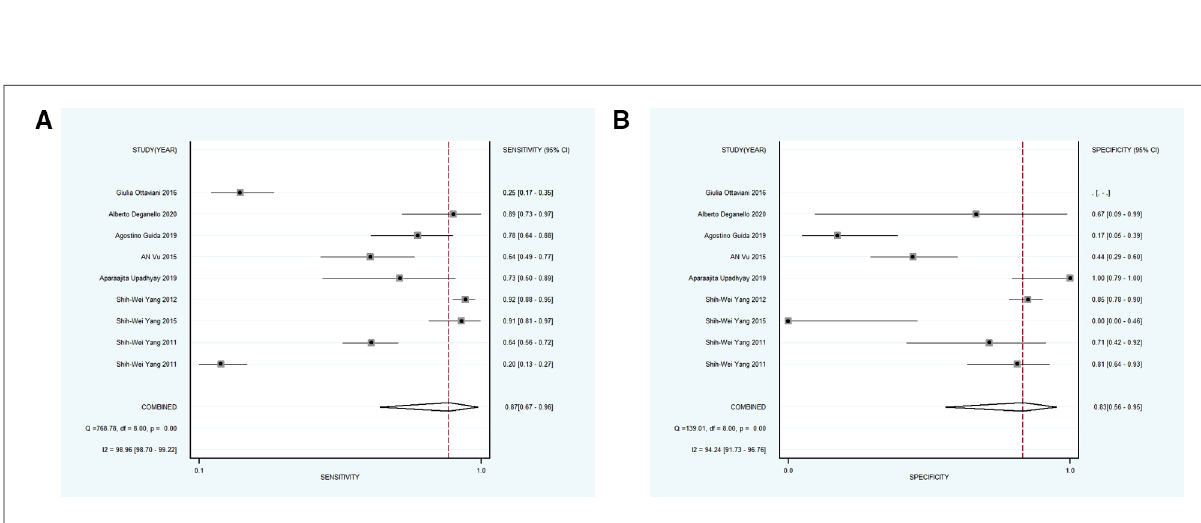
FIGURE 3 ( A,B ) forest plot of sensitivity and speci fi city of subgroup 1 regarding the diagnostic accuracy of NBI for the malignant transformation of